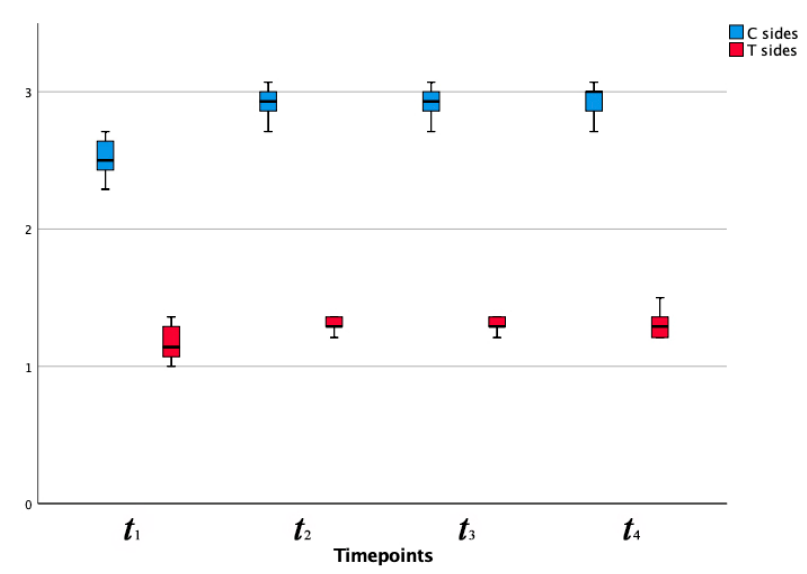
Figure 5. LPAI trend during the study.